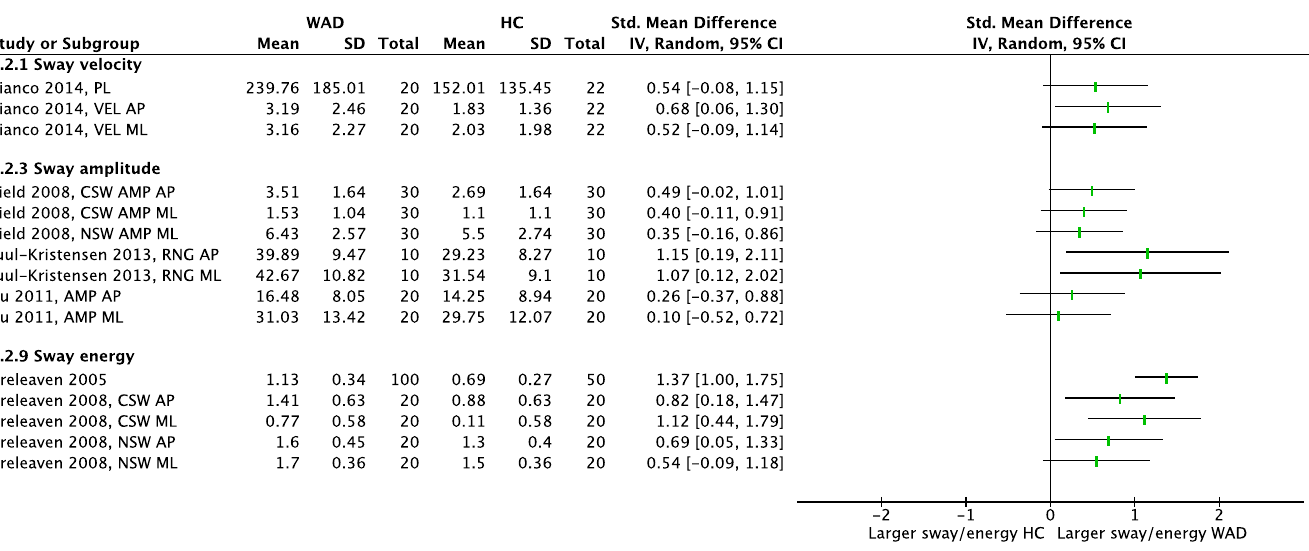
Fig 8. Forest plot, without meta-analysis, demonstrating sway velocity, sway amplitude and sway energy (eyes closed) in people with WAD vs. HC. WAD: whiplash-associated disorder; HC: healthy control; SD: standard deviation; IV: inverse variance; CI: confidence interval; Std: standardized; VEL: mean velocity (mm/s); PL: path length (mm); RNG: range (mm); AMP: amplitude (mm); AP: anteroposterior; ML: mediolateral; CSW: comfortable stance width; NSW: narrow stance width.